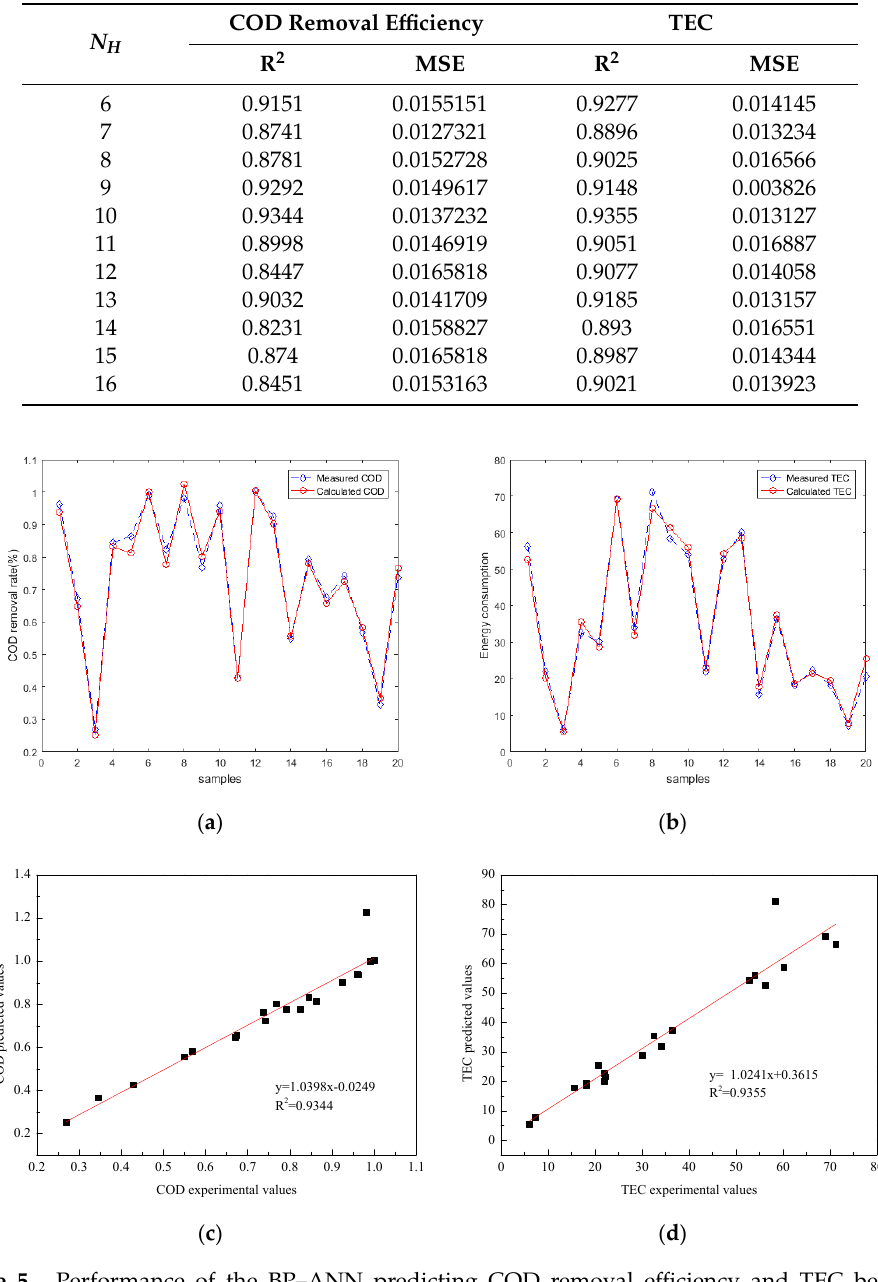
Table 3. Evaluation of the prediction performance of the BP-ANN model for the testing dataset.